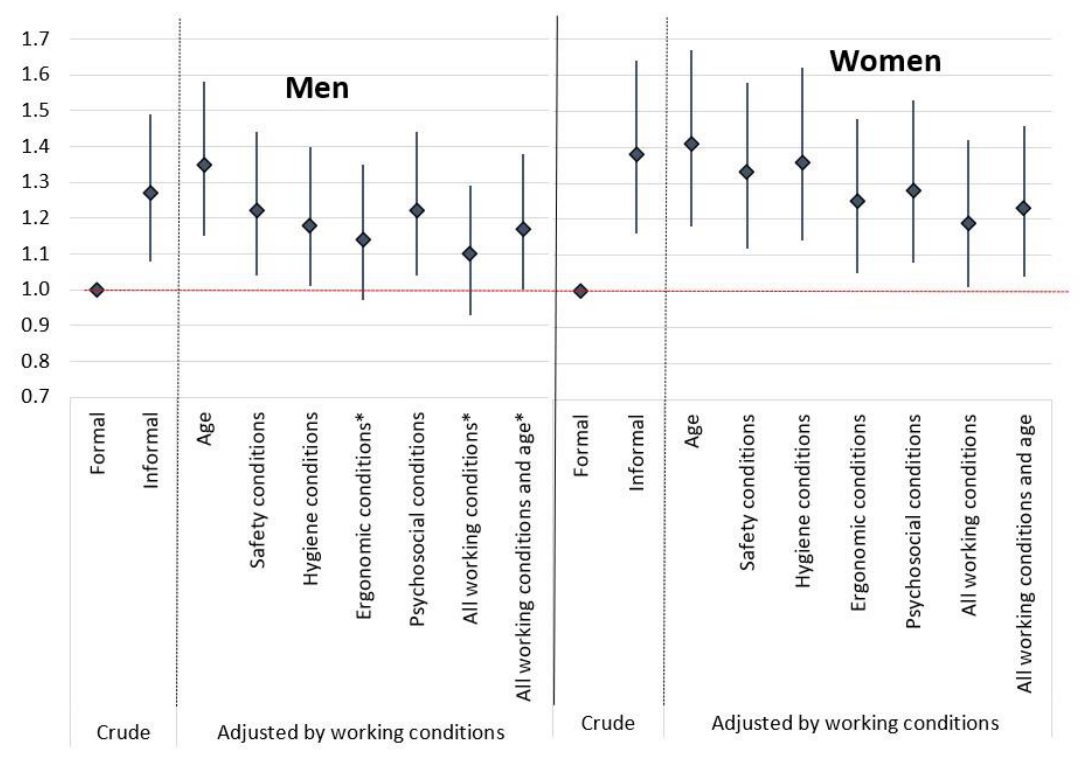
Figure 1. Prevalence ratios (PR) of poor self-perceived health between informal and formal employees (reference category), both crude and adjusted by working conditions and age with 95% confidence intervals (95% CI), working conditions survey of Peru 2017. Working conditions were treated as a continuous variable, and the possible responses in which each category represented a numerical value on the Likert scale (always = 5, many times = 4, sometimes = 3, rarely = 2 and never = 1, except for positive psychosocial conditions phrased positive that scored the other way around) were summed in a score by each working condition dimension (safety, hygiene, ergonomic, psychosocial). * The chi-square statistic is not significant at the 0.05